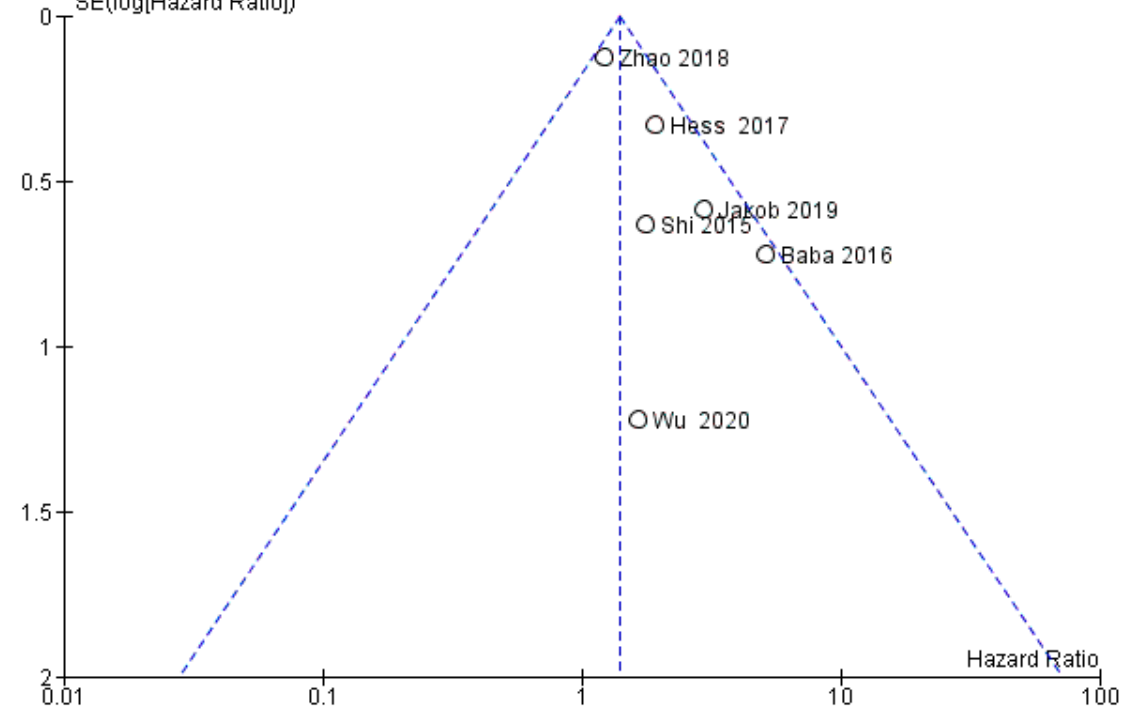
Figure 5. Funnel plot for the first meta-analysis, I 2 = 28%. The absence of heterogeneity is highlighted graphically. SE: standard error.